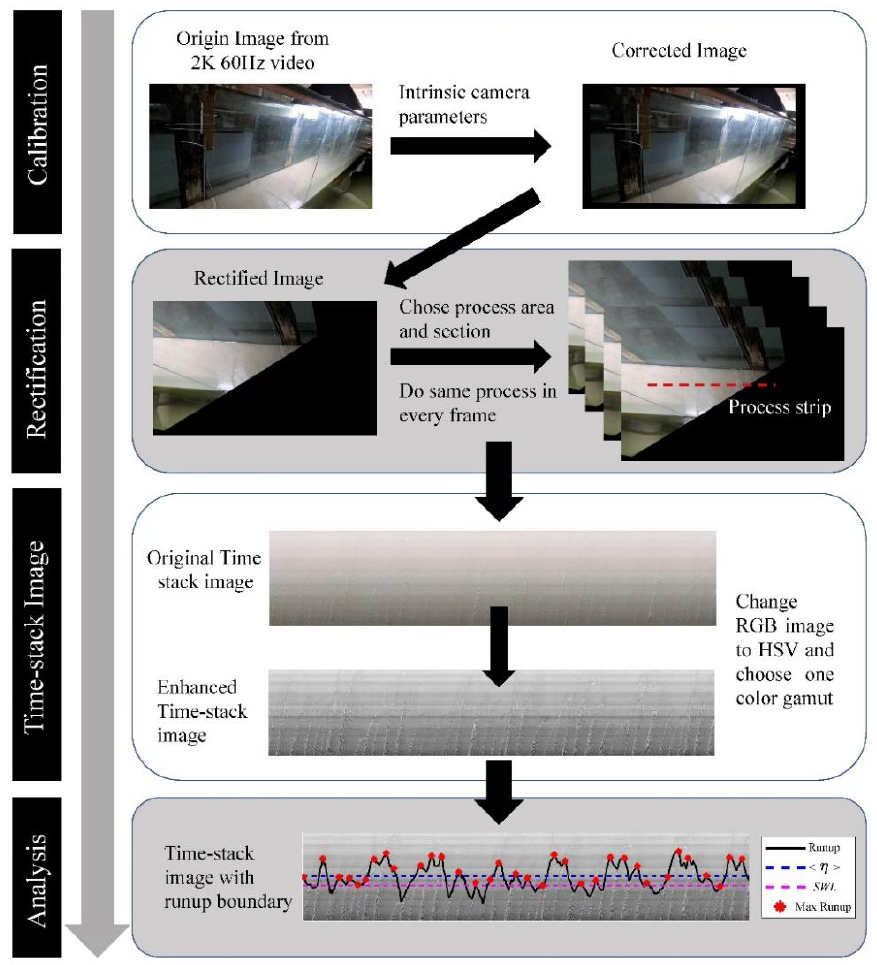
Figure 2. Image process flow diagram in the experiment.